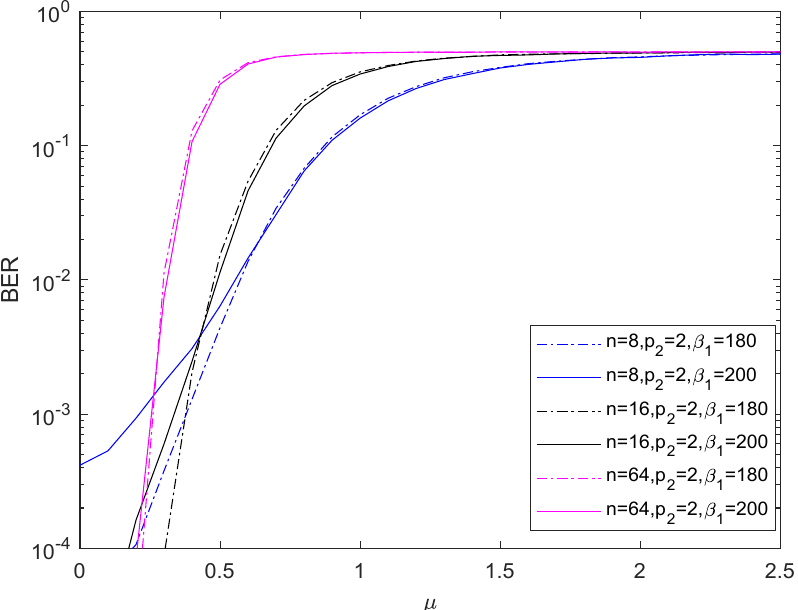
Figure 2. BER performance of GCI-DCSK SWIPT changes along with µ over AWGN channel with P s / N 0 = 18 dB.